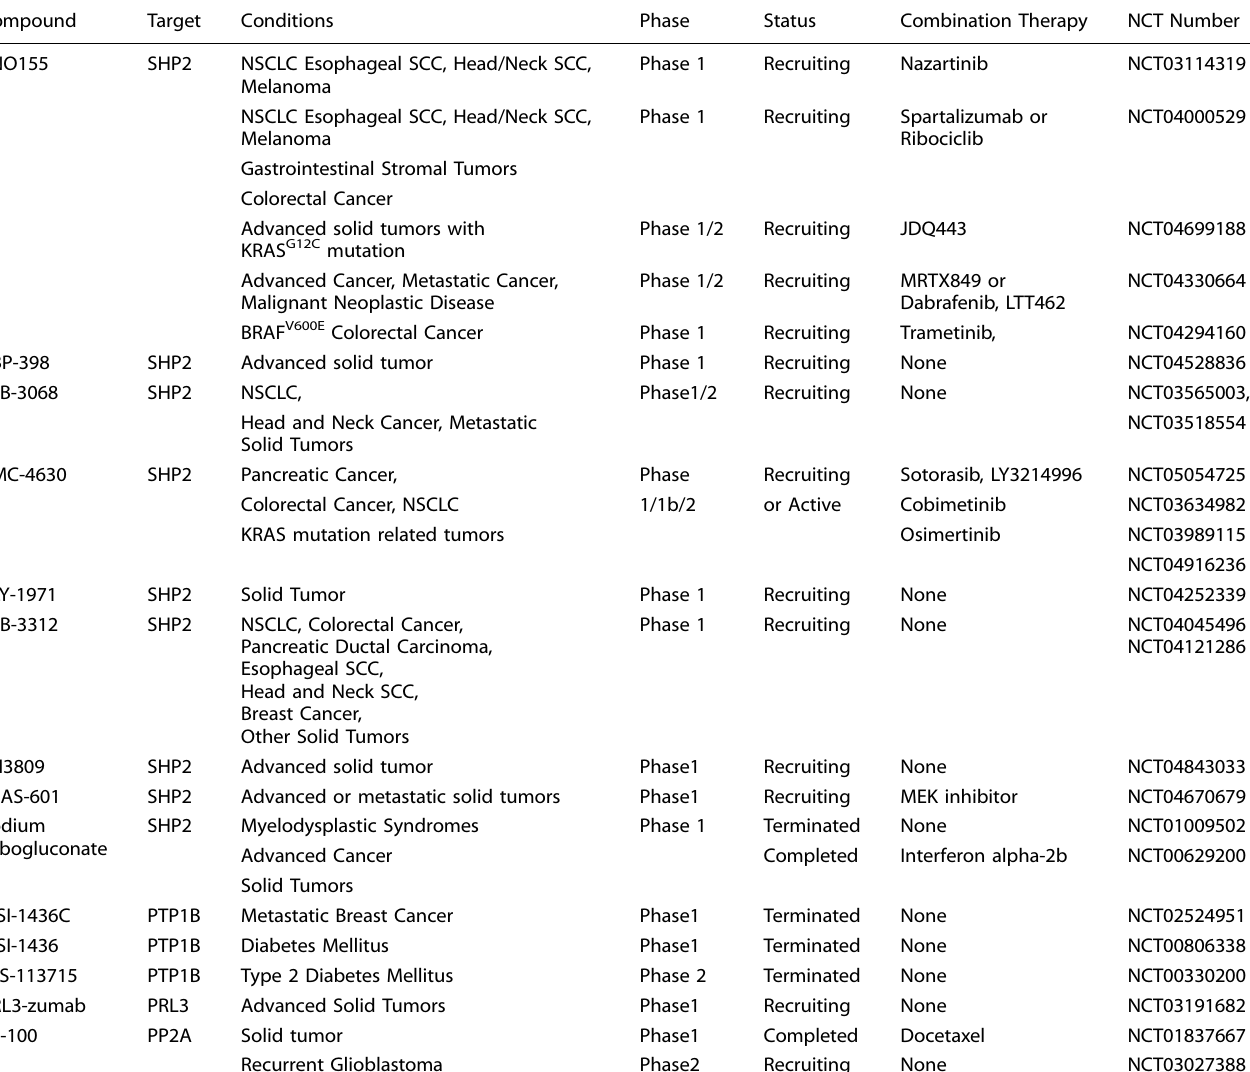
Table 3. Drugs targeting protein phosphatases involved in in fl ammation in clinical trials